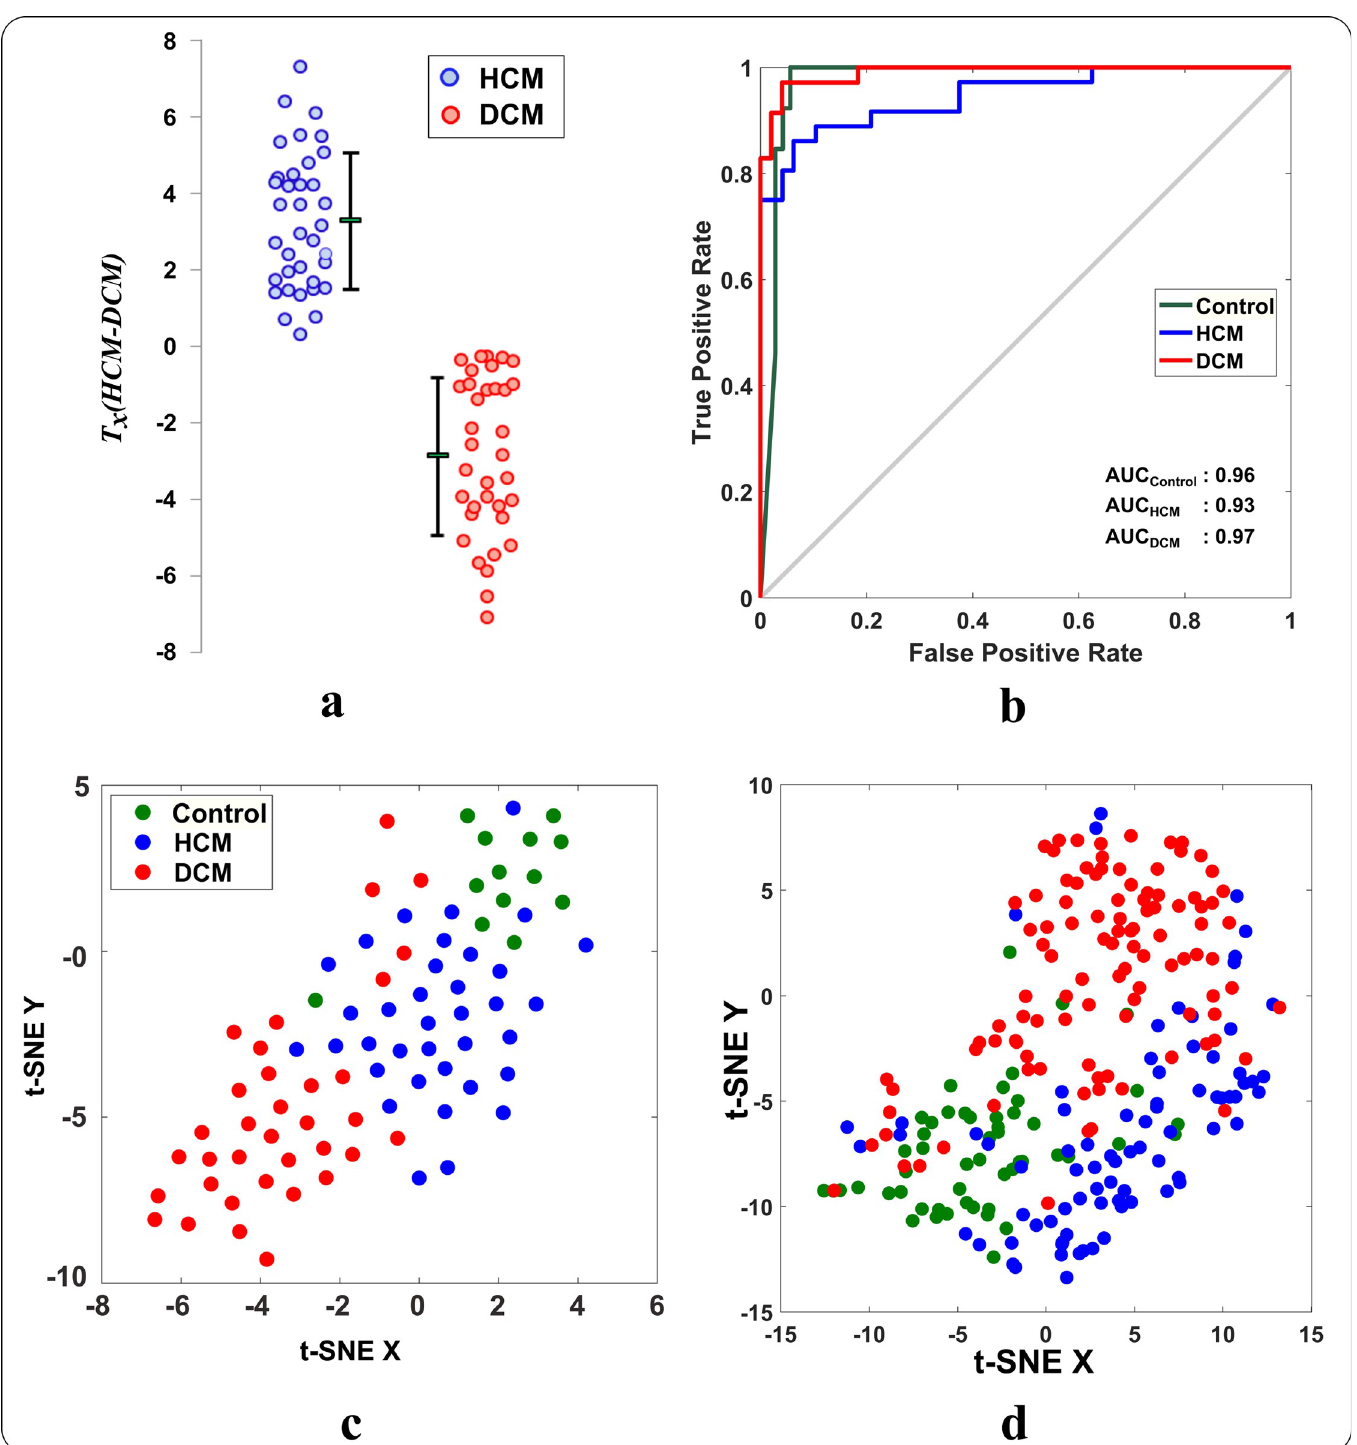
Fig 5. The capacity of the pattern-derived texture features to identify subjects from different cohorts in the testing dataset. (a) the texture index (T x ) for patients in HCM and DCM cohorts (i.e. calculated by combining the select features using a linear regression model). Each dot represents the T x value for one patient. (b) ROC curves for multi-cohort classification performance of selected features to identify subjects in control, HCM and DCM cohorts in the testing dataset by SVM. The t-SNE visualization of the selected features for all cohorts in (c) the testing and (d) training dataset. Each dot represents pattern-derived features of one subject.